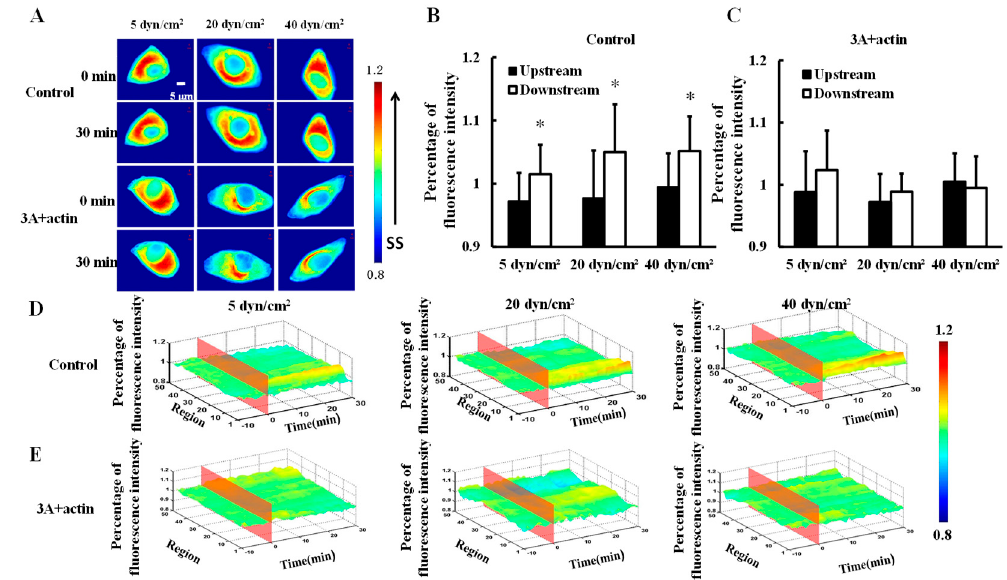
Figure 3. Effect of HSP27 phosphorylation on shear-stress-induced actin polar distribution. ( A ) Fluorescence images of HeLa cells transfected with mCherry-actin (control) and cells